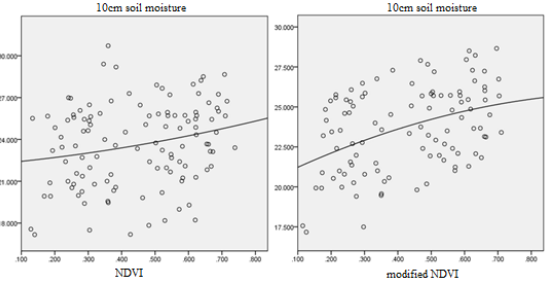
Figure 3. Regression curve of 10cm soil moisture on NDVI and modified NDVI in 2.10 in central Henan